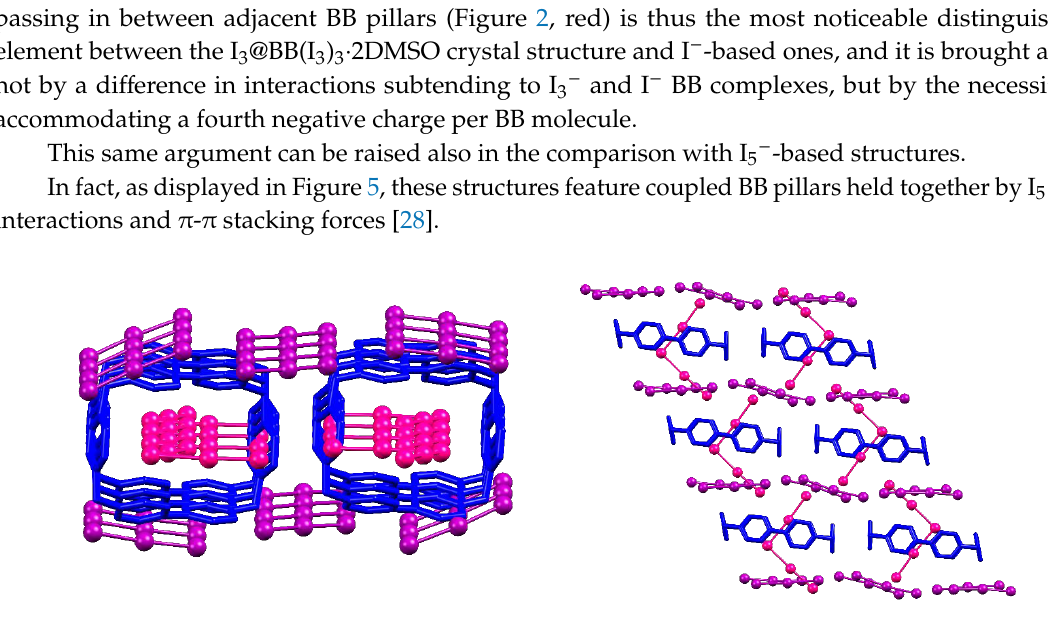
Figure 5. Front and top view of coupled BB pillars as found in the I 5 @(BB)(I 3 ) 3 crystal